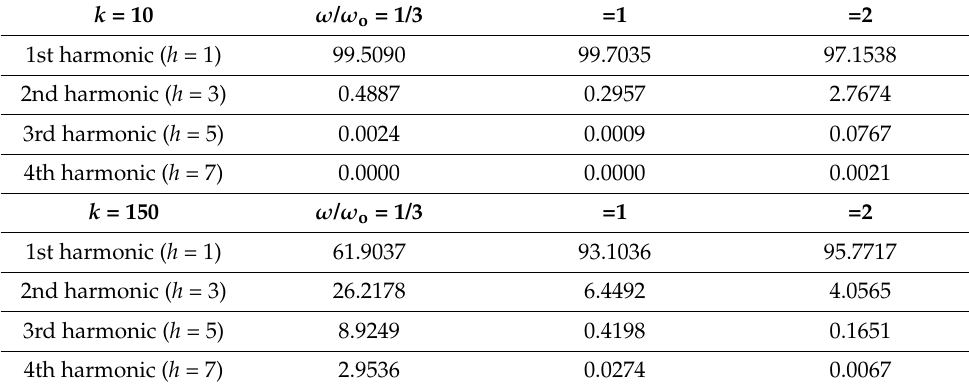
Figure 3. Amplitude ratio versus excitation frequency for various excitation magnitudes ( c/a = 0.5, ξ = 0.02, single cavity).